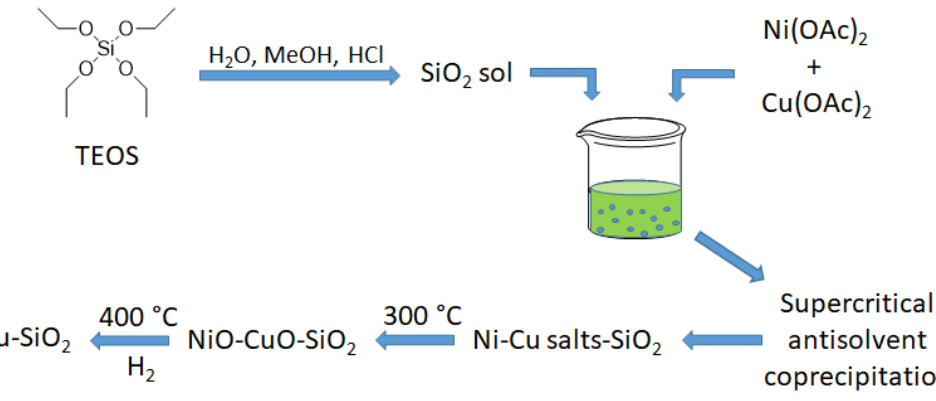
Figure 9. Scheme of catalyst preparation via supercritical antisolvent coprecipitation.